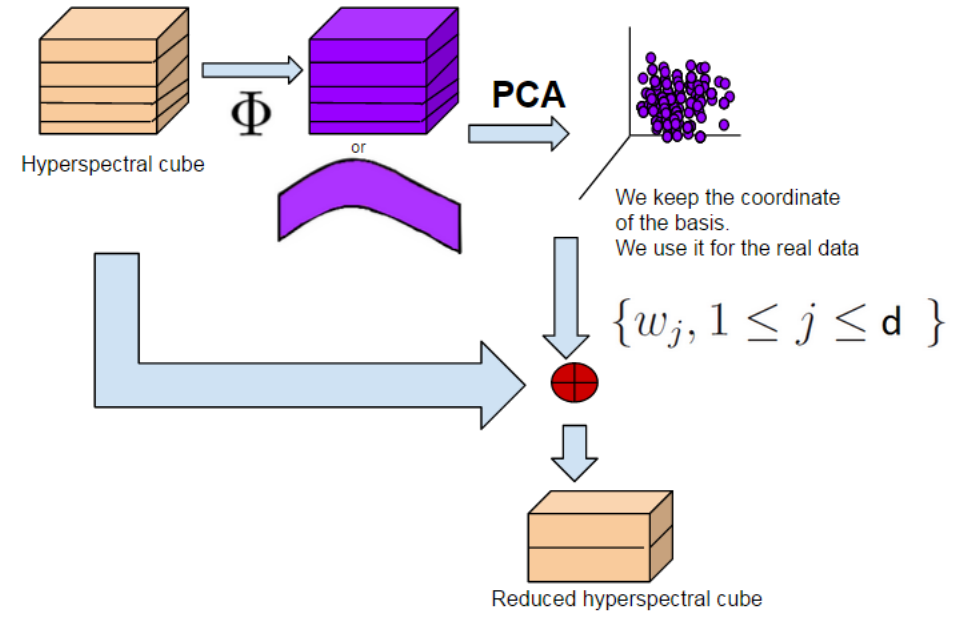
Figure 4. Global process of MorphPCA.